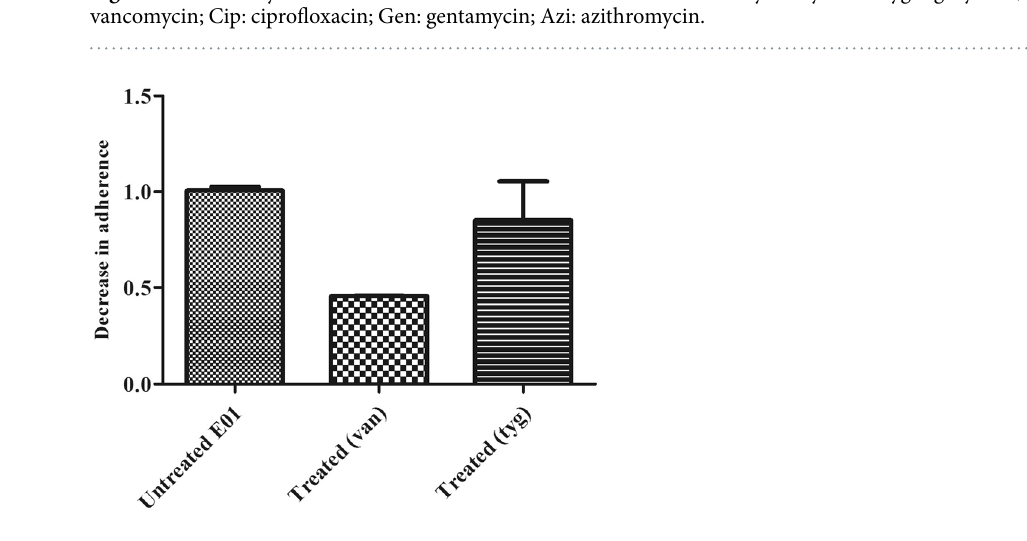
Figure 6. Effect of sub-MIC of some antibiotics on biofilm formation in a representative strong biofilm- forming isolate